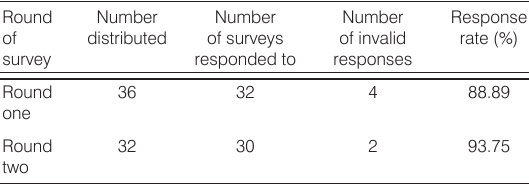
Table 4. Survey for confirming the scope of practice of prescriptive authority for midwives in specific